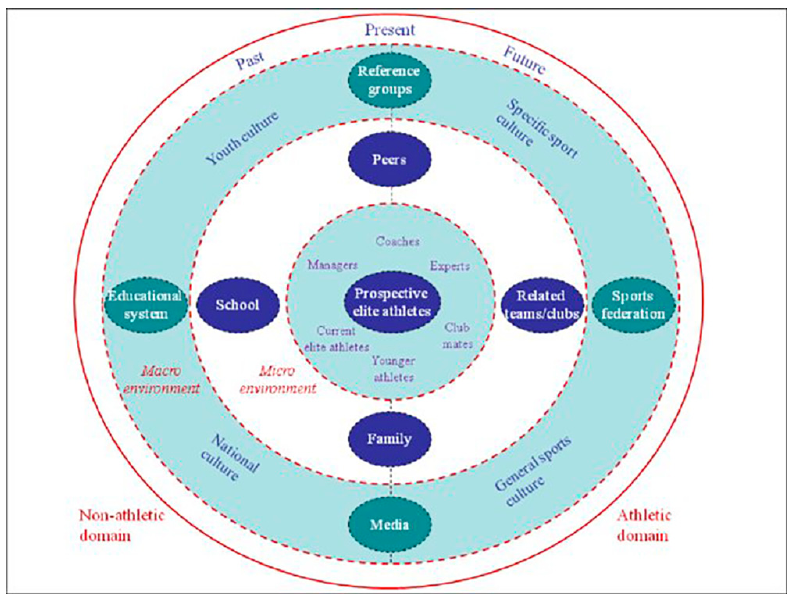
Figure 1. The “ATDE” model ([35 ] , p. 39).